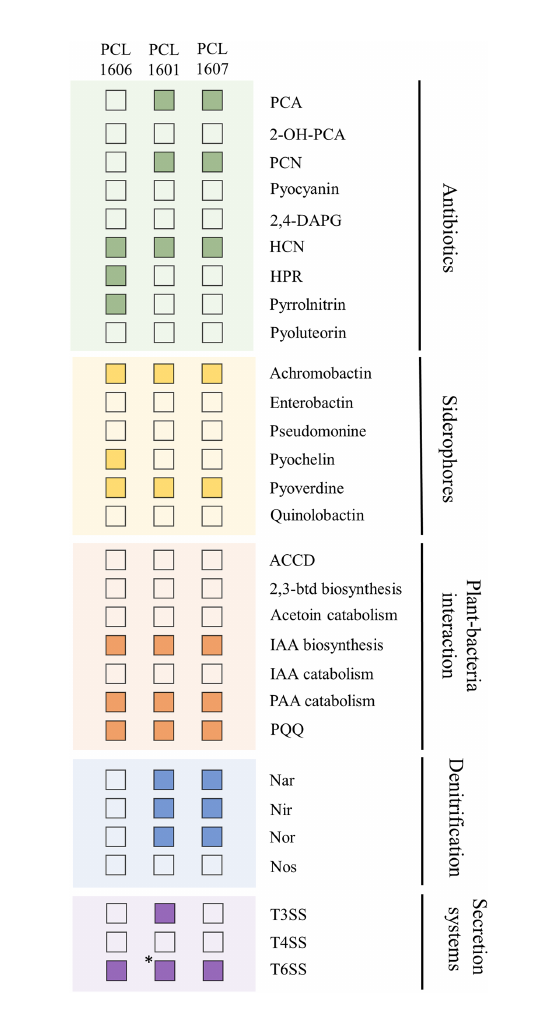
FIGURE 2 Positive ( fi lled square) and negative (empty square) matches from a BLASTp search of PGP-related activities in the genomes of the selected Pc strains. PCA, phenazine-1-carboxylic acid; 2-OH- PCA, 2-hydroxyphenazine-1-carboxylic acid; PCN, phenazine-1- carboxamide; 2,4-diacetyphloroglucinol HCN, hydrogen cyanide; HPR, 2-hexyl-5-propyl resorcinol; ACCD, 1- aminocyclopropane-1-carboxylate deaminase; 2,3-btd, 2,3- butanediol; IAA, indol-3-acetic acid; PAA, Phenylacetic acid; PQQ, pyrroloquinoline. *: presence of 7 of 8 genes considered for a functional T3SS by software